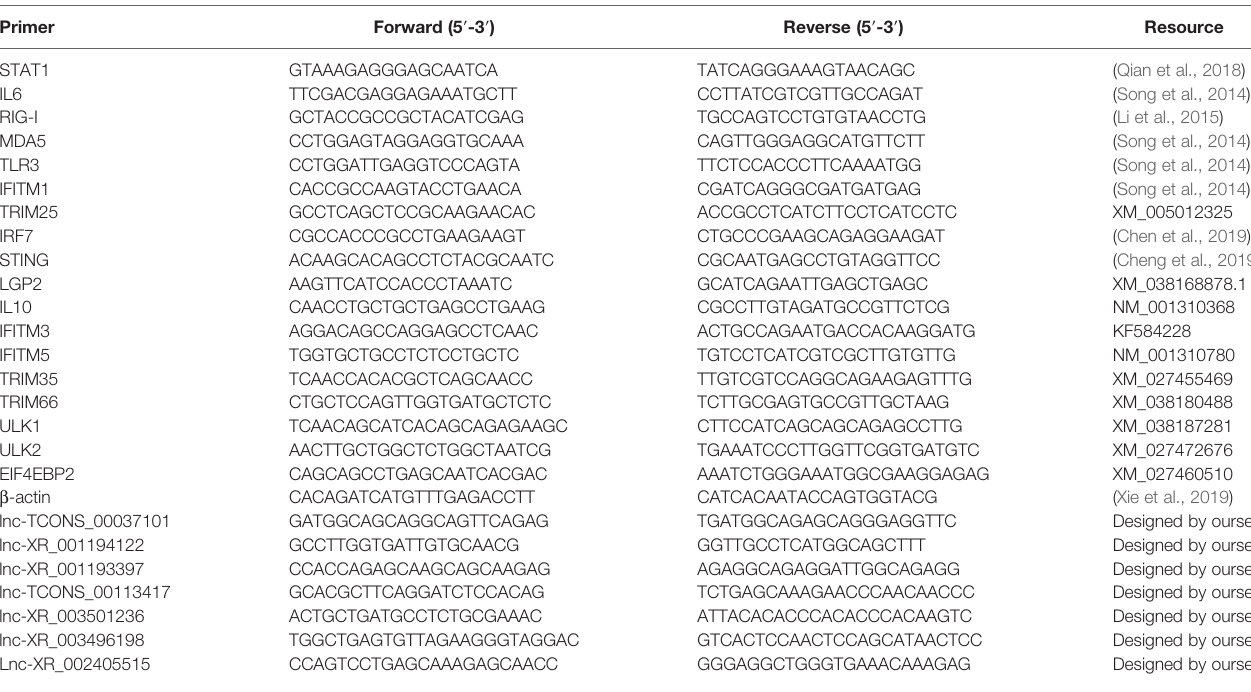
TABLE 1 | Primers used in this